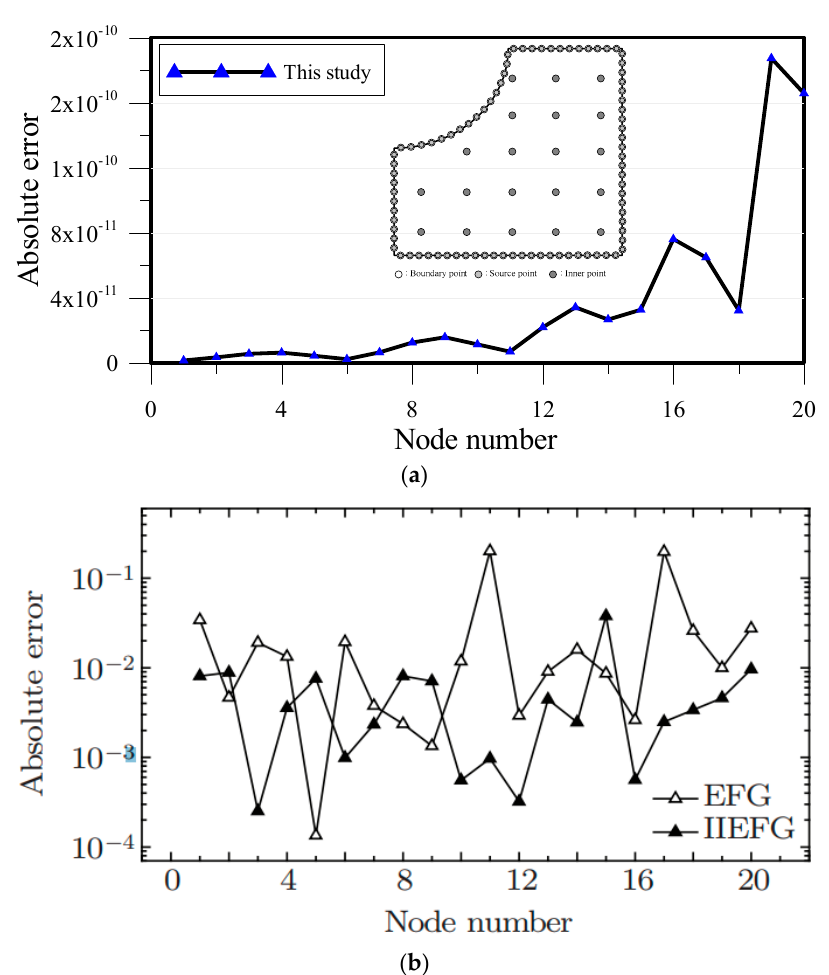
Figure 9. Comparison of computed results of the proposed method. ( a ) Comparison of results with the analytical solution and ( b ) comparison of results with the EFG and the IIEFG methods.